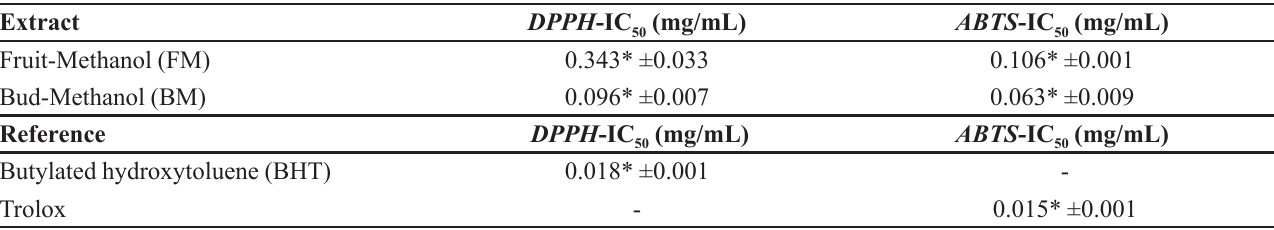
TABLE II - Antioxidant activity results of C. ovata var. palaestina extracts